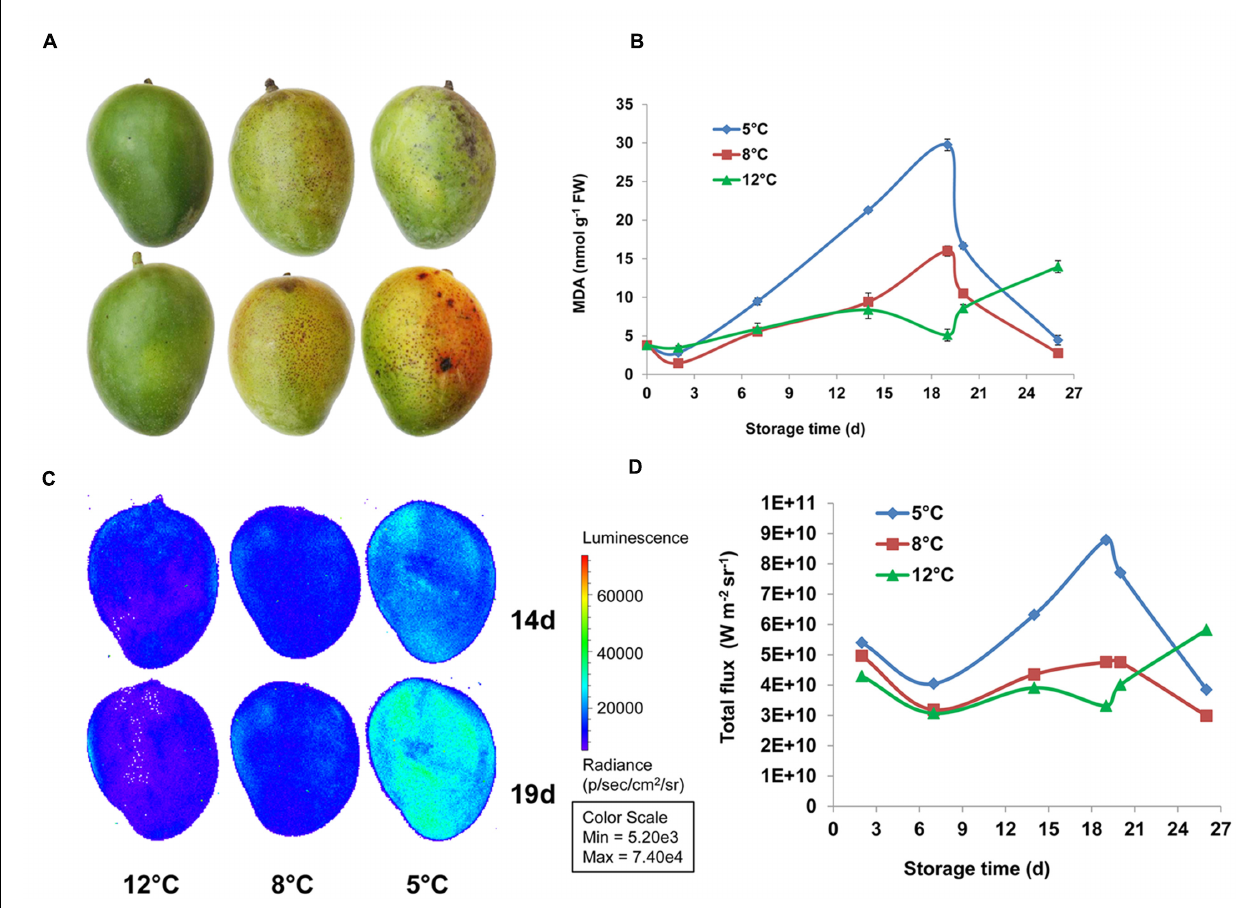
FIGURE 8 | Lipid peroxidation observed in mango during cold storage. (A) Representative pictures of fruit stored at 12 ◦ C (left panel), 8 ◦ C (middle panel), and 5 ◦ C (right panel) for 19 days. (B) Malondialdehyde (MDA) concentration in mango fruit peel stored for 19 days at 12 ◦ C (green), 8 ◦ C (red), or 5 ◦ C (blue) and transferred to 20 ◦ C for the remaining 8 days. (C) Representative pictures of luminescing peroxide lipids in fruit stored at 12 ◦ C (left panel), 8 ◦ C (middle panel), 5 ◦ C (right panel) for 14 days (upper panel) or 19 days (lower panel). (D) Quantification of luminescence (as presented in C ) in mango fruit stored for 19 days at 12 ◦ C (green), 8 ◦ C (red), or 5 ◦ C (blue) and transferred to 20 ◦ C for the remaining 8 days, values are presented as W m − 2 sr − 1